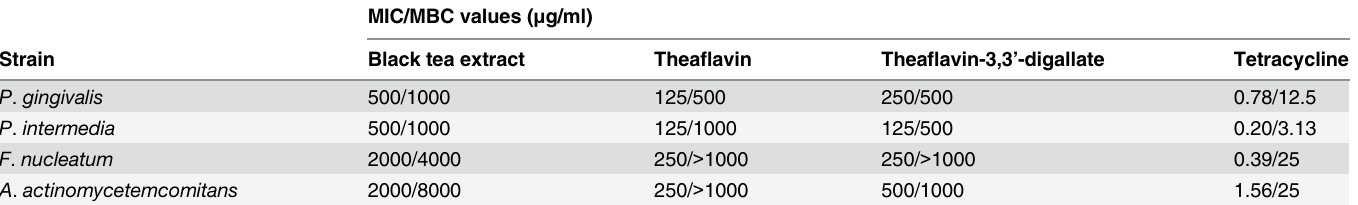
Table 1. Minimal inhibitory concentration (MIC) and minimal bactericidal concentration (MBC) values of the black tea extract, theaflavin, theafla- vin-3,3 ’ -digallate, and tetracycline against four periodontopathogenic bacterial species.